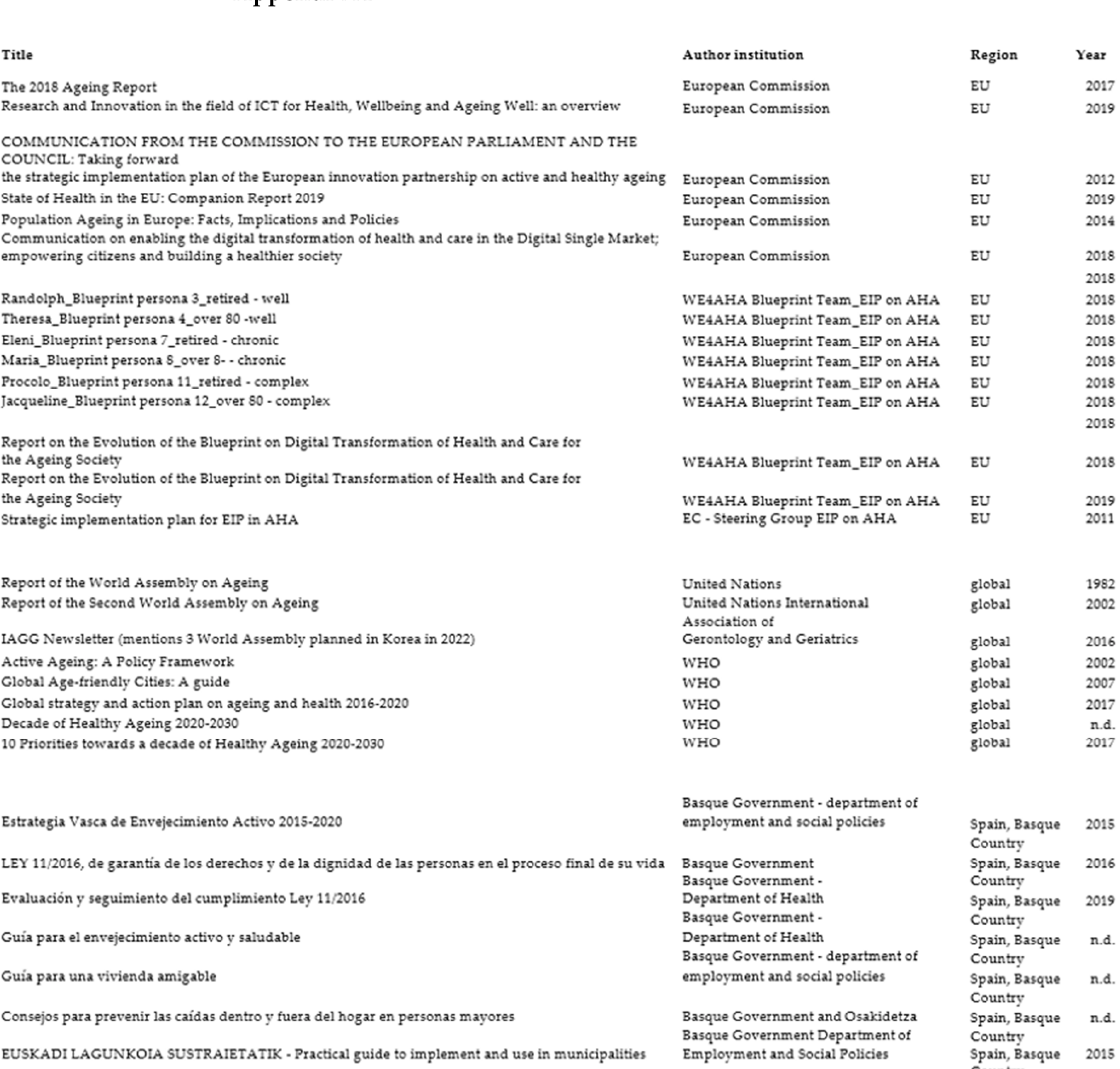
Figure A1. First round of ageing policy discourse document collection.